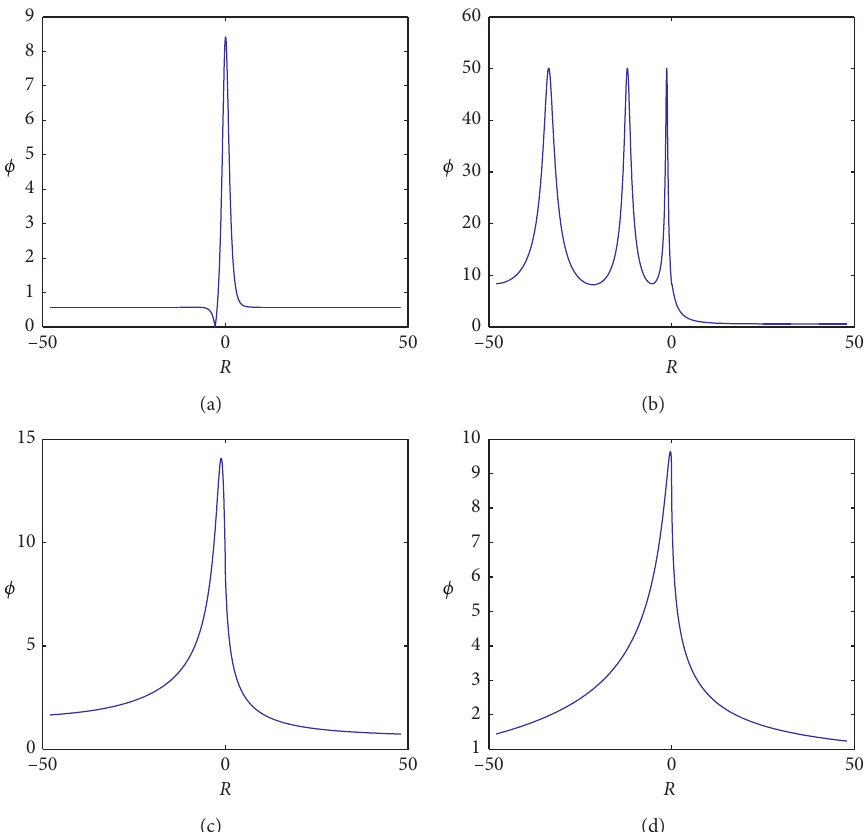
Figure 5: The values of the parameters are as follows. (a) β and ϖ � 1. (c) β